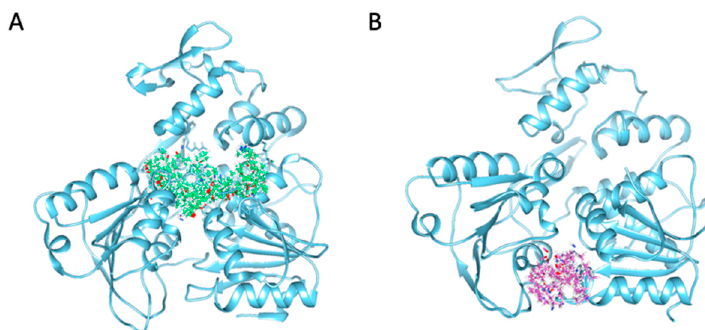
Figure 1. Molecular demonstration of the docking modes generated according to the binding grooves of ( A ) single-stranded RNA (ssRNA) (protein data bank (PDB) ID: 5GJB, shown in spring green) and ( B ) nucleoside triphosphate (NTP) (PDB ID: 5GJC, shown in pink within Zika virus (ZIKV) non-structural protein 3 helicase (NS3Hel) (shown in sky blue).